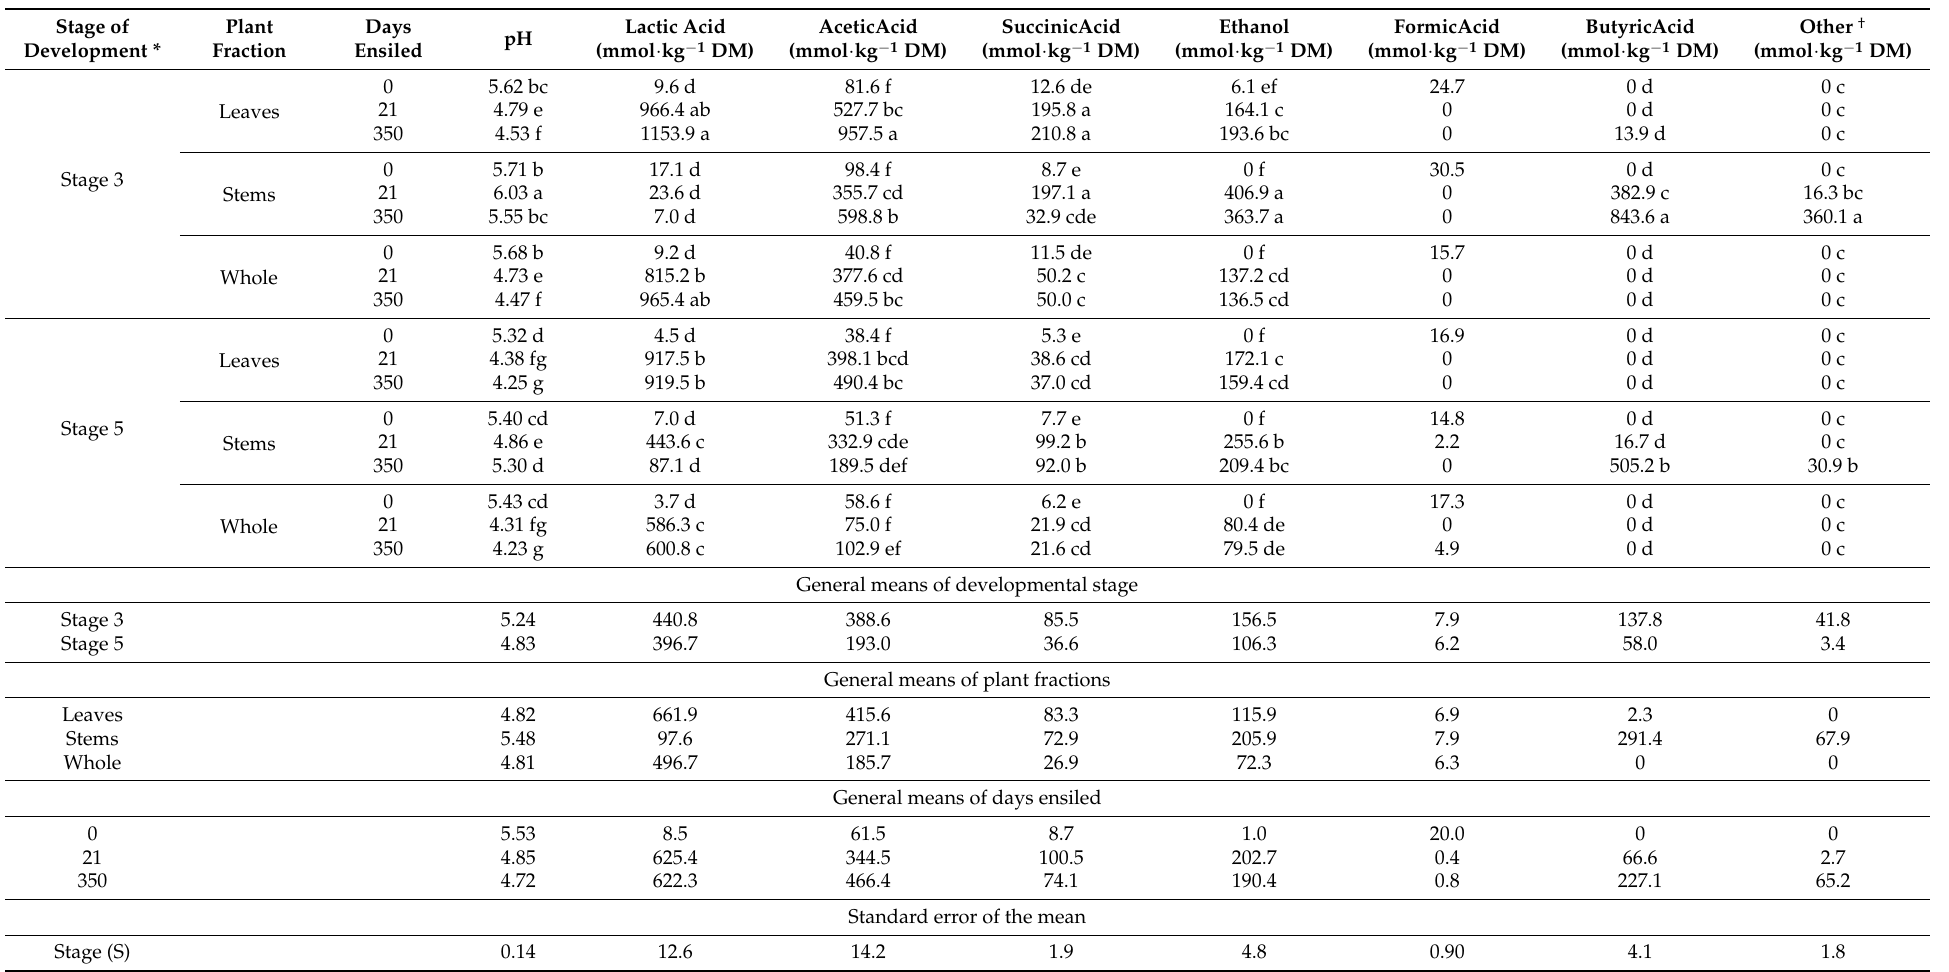
Table 2. Fermentation characteristics of alfalfa leaf, stem, and wilted whole-plant silages at two developmental stages before and after